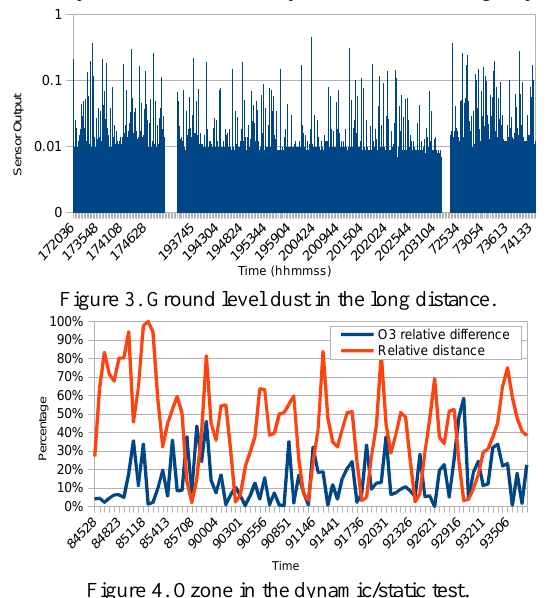
Figure 4. Ozone in the dynamic/static test.